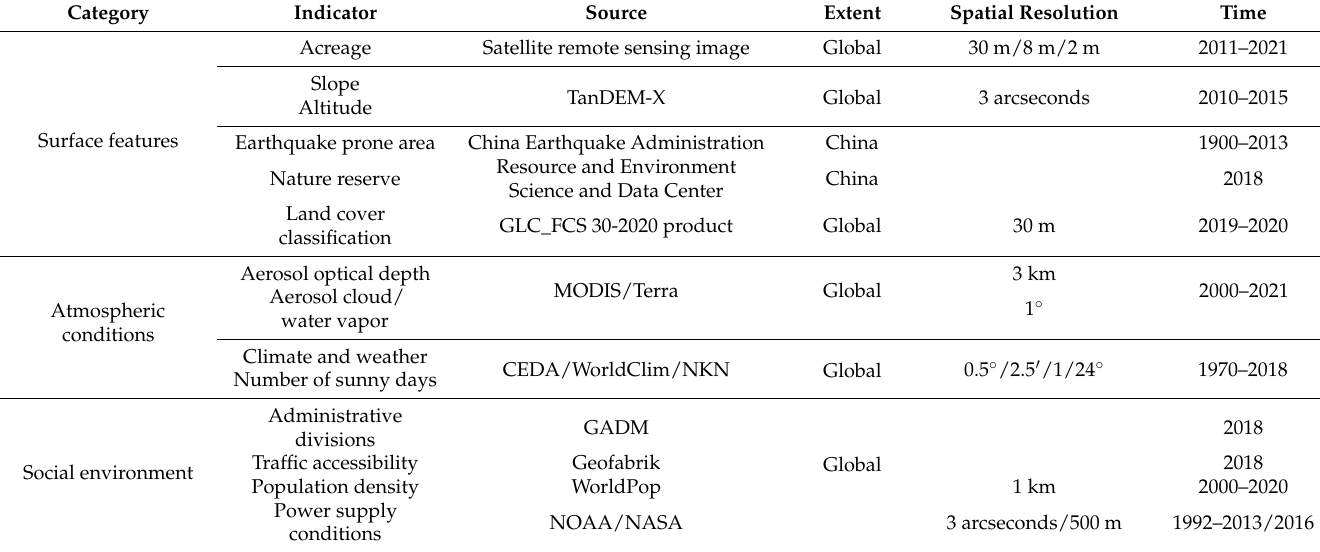
Table 1. Source and introduction of the evaluation indicator